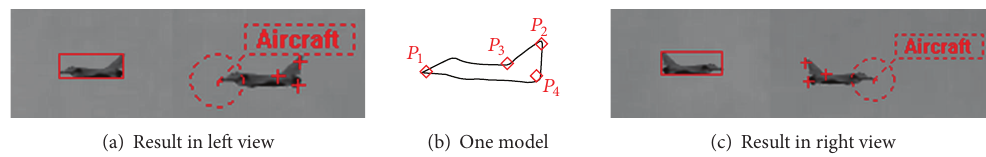
Figure 12: Detection and tracking results based on one model.